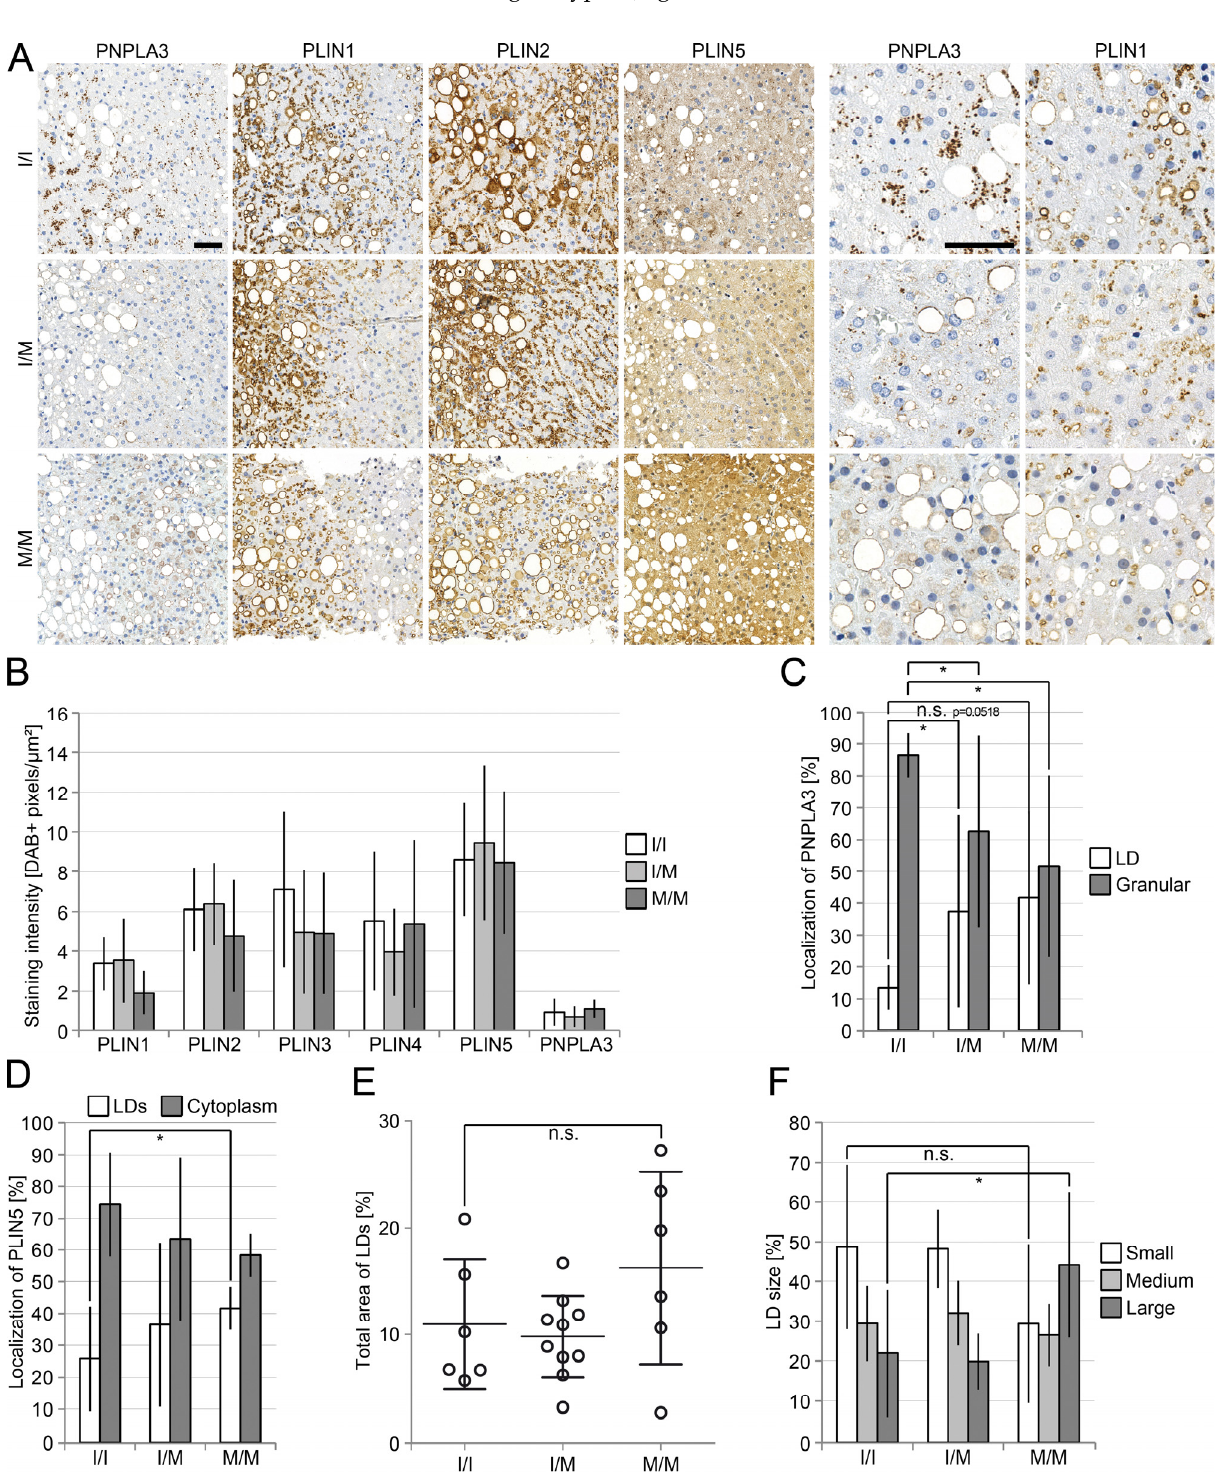
Figure 1. Reduced immunohistochemical perilipin 1, 2 and 3 staining in NASH-livers in homozygous PNPLA3(I148M)-carriers. ( A ) Immunohistochemical analysis of perilipin 1–5 and PNPLA3 in a collective of 23 liver biopsies from NASH-patients with known PNPLA3 -status (I/I n = 7, I/M n = 10 and M/M n = 6). Hepatocytes strongly positive for PNPLA3 showed diminished perilipin 1-expression, especially in homozygous PNPLA3(I148M)-carriers. Scale bars: 50 µm; ( B ) analysis of the staining intensity (DAB-positive pixels/µm²) performed with the image analysis software QuPath. Livers of homozygous PNPLA3(I148M)-carriers showed a slight reduction in perilipin 1, 2 and 3-staining ( p = 0.0561; p = 0.3529; p = 0.2904); ( C ) comparative scores of PNPLA3- localization to LDs (white) or granular structures (grey) in hepatocytes (0–4) demonstrated that LD-